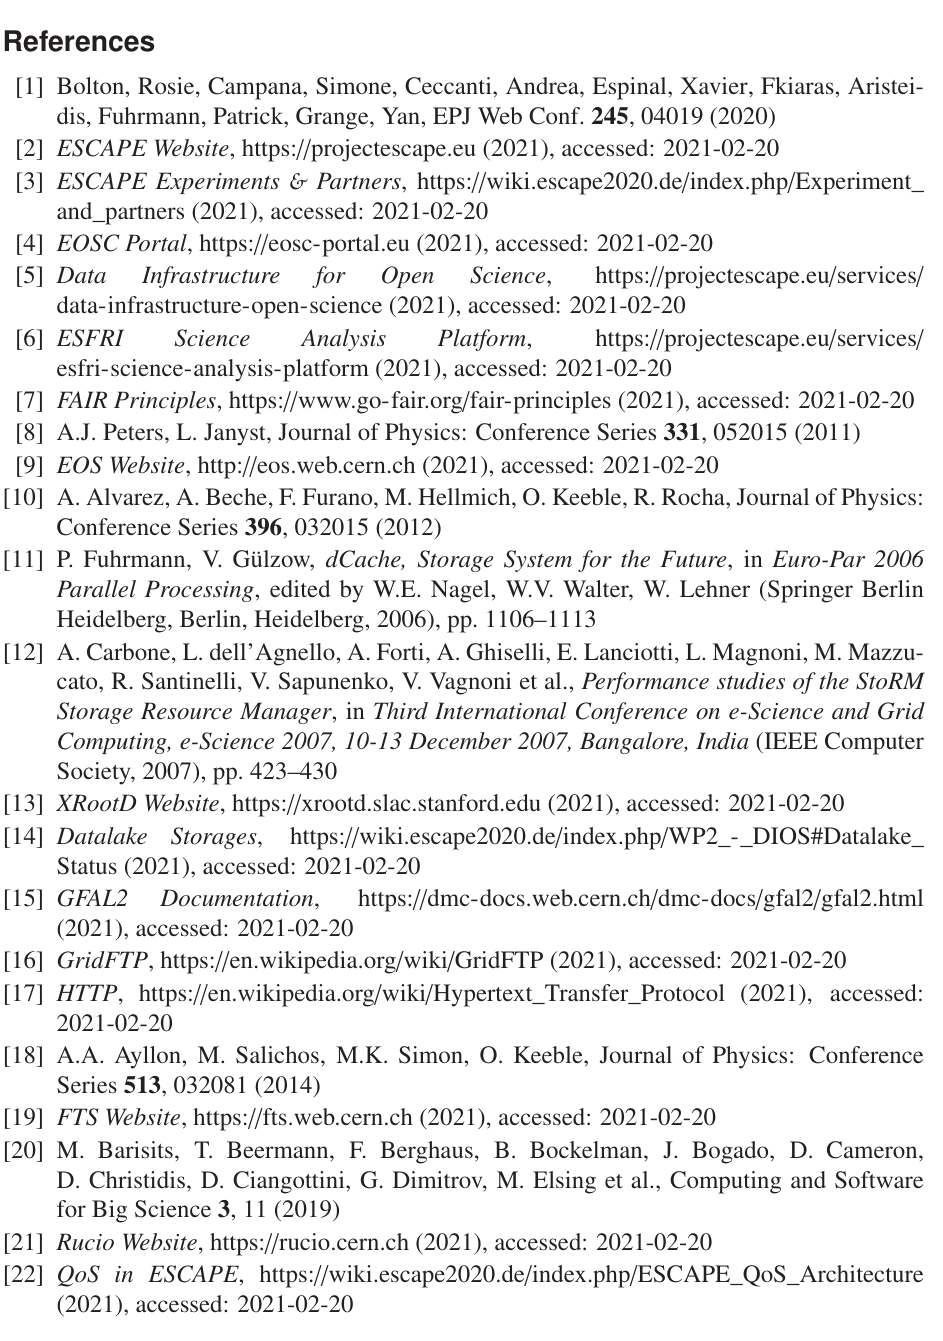
Figure 6: Used storage over time for experiments (FDR day)